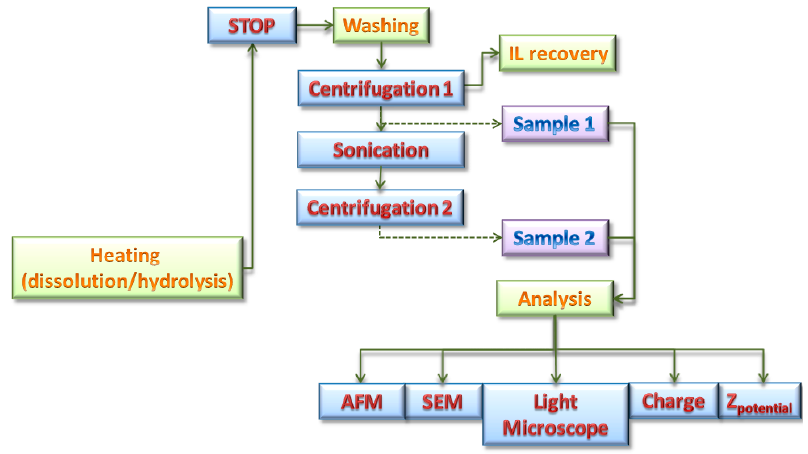
Figure 1. Schematic procedure for dissolution / hydrolysis of BHKP on ILs.